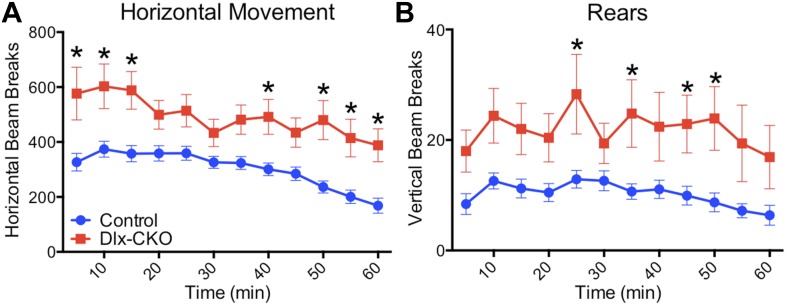
Dlx-CKO mice are hyperactive.(A) Open field analysis of horizontal movements (two-way ANOVA main effect of genotype F1,35 = 16.29, p = 0.0003; time F11,385 = 12.72, p < 0.0001; interaction F11,385 = 1.713, p = 0.06, Bonferroni's multiple comparisons test). (B) Open field analysis of vertical movements (two-way ANOVA main effect of genotype F1,35 = 10.72, p = 0.002; time F11,385 = 4.176, p < 0.0001; interaction F11,385 = 1.07, p = 0.37, Bonferroni's multiple comparisons test).